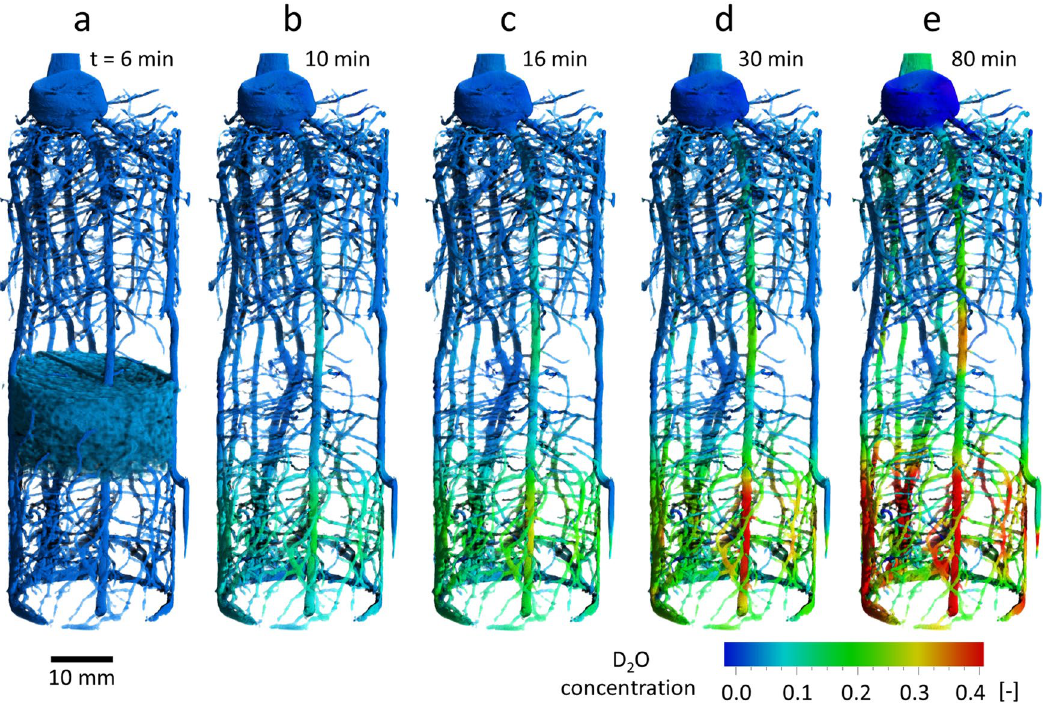
Figure 5. Tomographic time series of the segmented maize root system showing the evolution of local D 2 O concentration in the root system reflecting water uptake and axial transport by individual roots. ( a ) Reference image taken six minutes after D 2 O infiltration, when the soil water distribution had become stagnant. The soil water